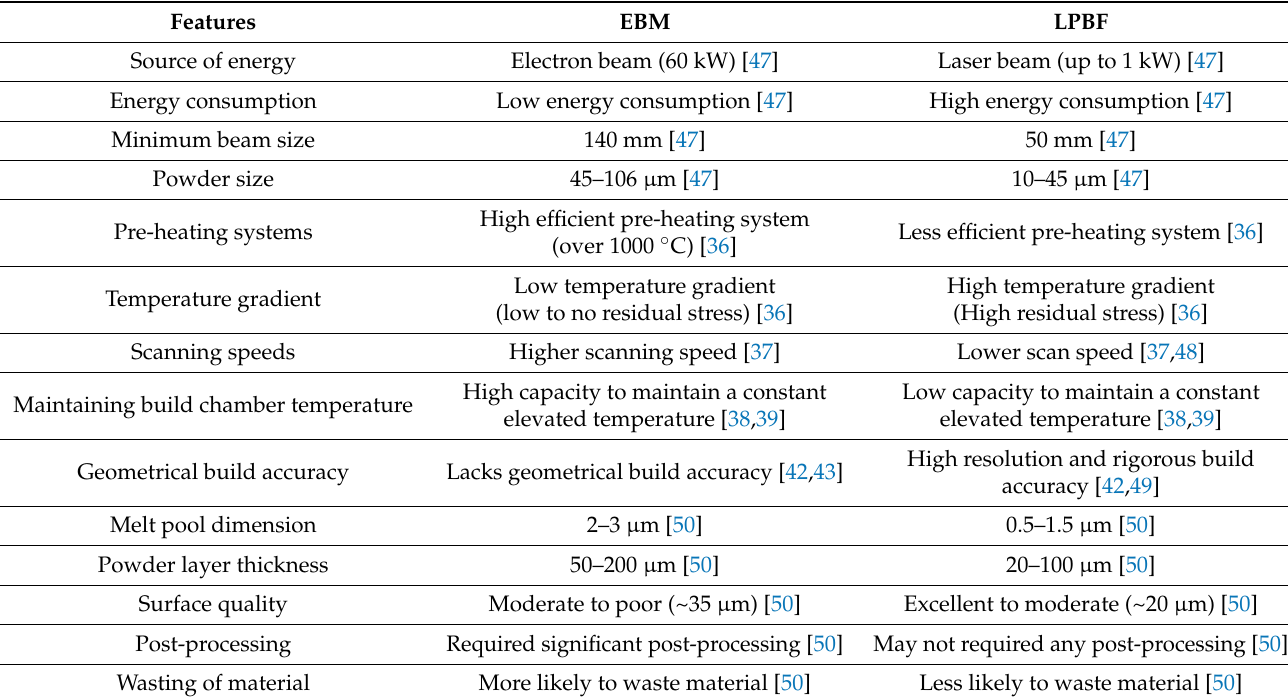
Table 1. Comparison between EBM and